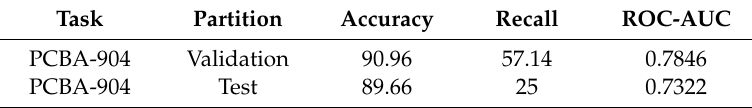
Table 3. Baseline results for the cancer candidate prediction models.